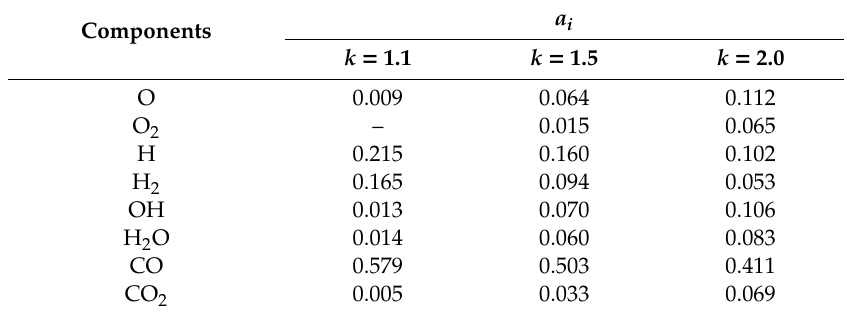
Table 1. Molar fractions a i of the major components of the detonation products of C 2 H 2 + k O 2